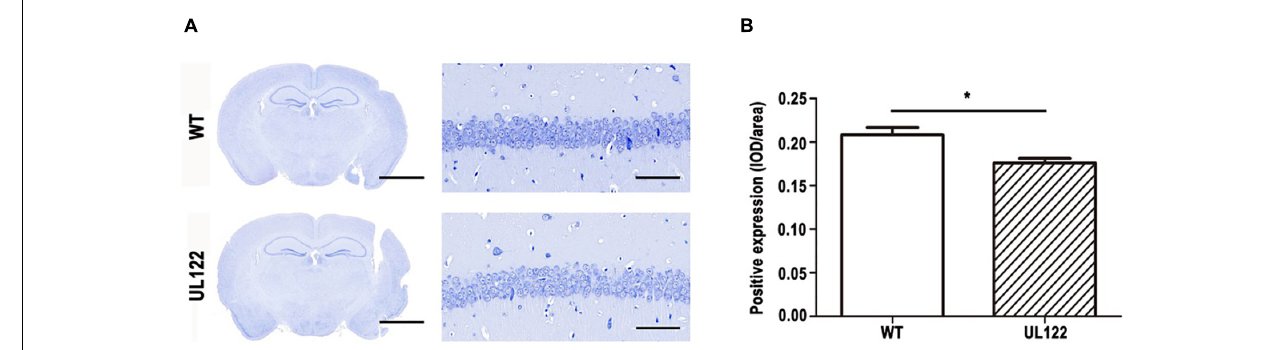
FIGURE 3 | Nissl staining in the hippocampal CA1 region of UL122 mice aged 12 months. (A) Nissl staining of the hippocampal CA1 region of mice aged 12 months. (B) Quantification of Nissl staining. Data were presented as mean ± SEM( n = 5 for each group). Statistical analysis was performed by unpaired t -test. * P < 0.05 vs. the control group. Scale bar on the left is 2,000 µ m, scale bar on the right is 50 µ m.